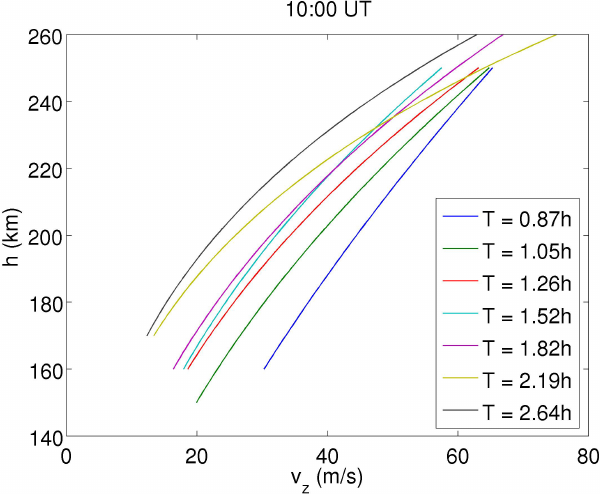
Figure 7. A few examples of height profiles of vertical phase ve- locity v z as resulting from the data of electron density on 20 Jan- uary 2010.